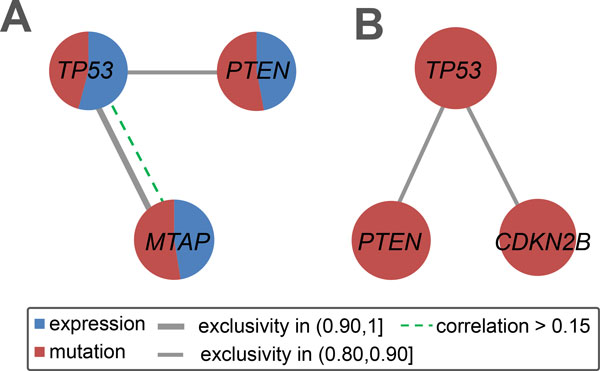
A comparison of the GBM data with or without gene expressions. (A) When all three kinds of data are used, the identified module has high exclusivity and relative correlation between TP53 and MTAP. (B) When gene expressions are not used the detected module is not as exclusive as before.